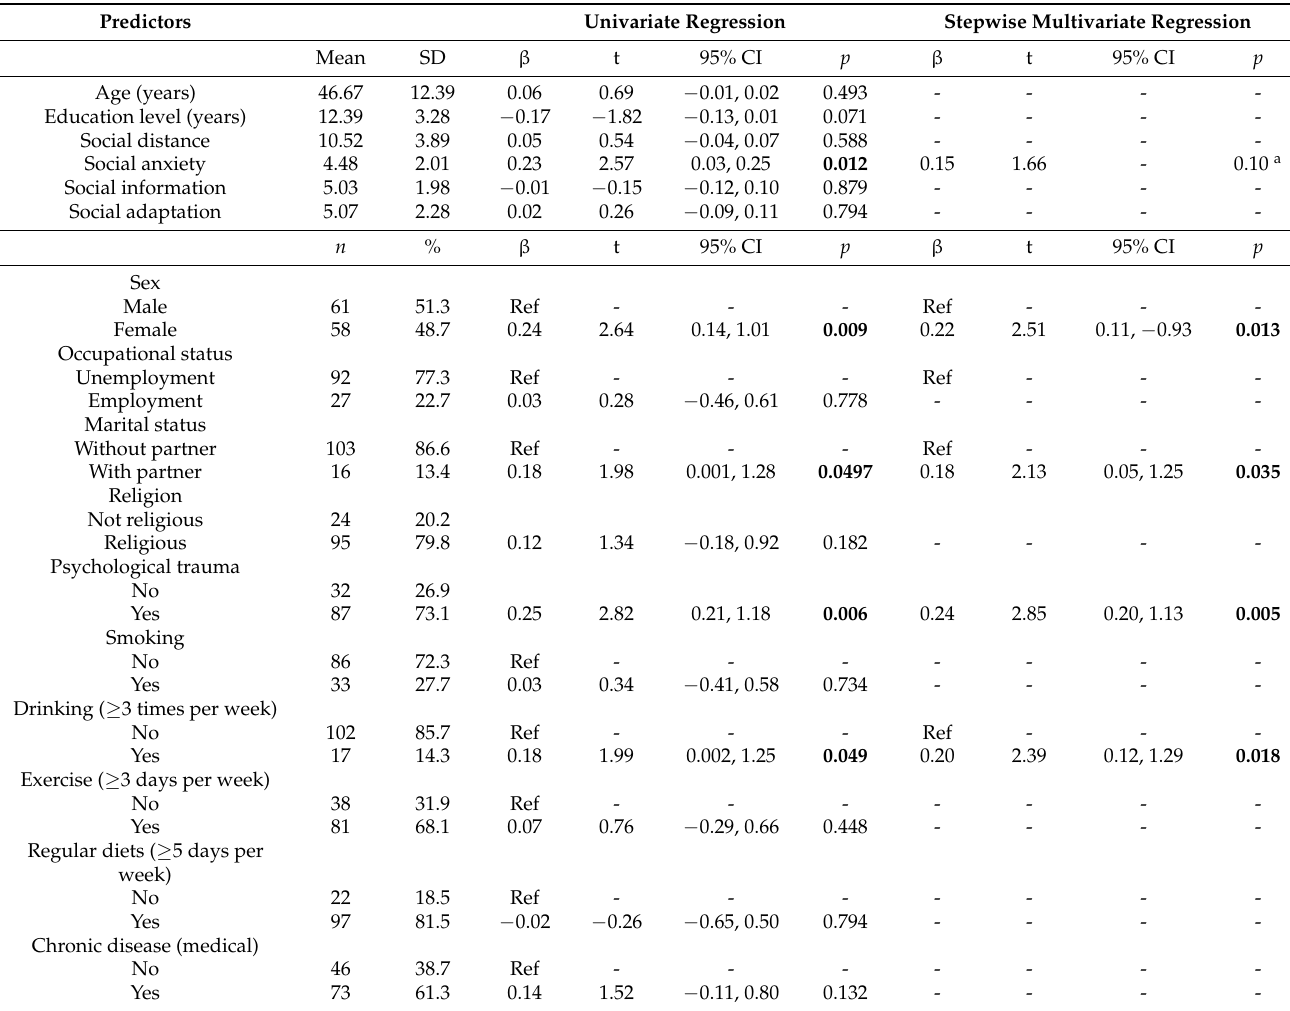
Table 1. Predictors for the level of depression examined by univariate linear regression and stepwise multivariate linear regression (N =